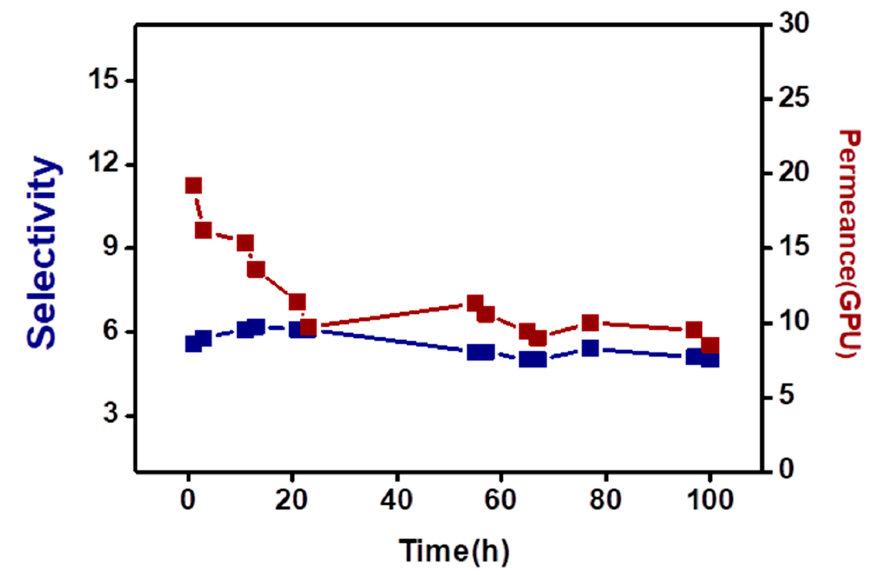
Polymers 2020 , 10 , x FOR PEER REVIEW 6 of Figure 4. Gas separation performance of PEBAX-2533 / metal salt / Al salt composite membrane over time. Figure 4. Gas separation performance of PEBAX-2533/metal salt/Al salt composite membrane over time.